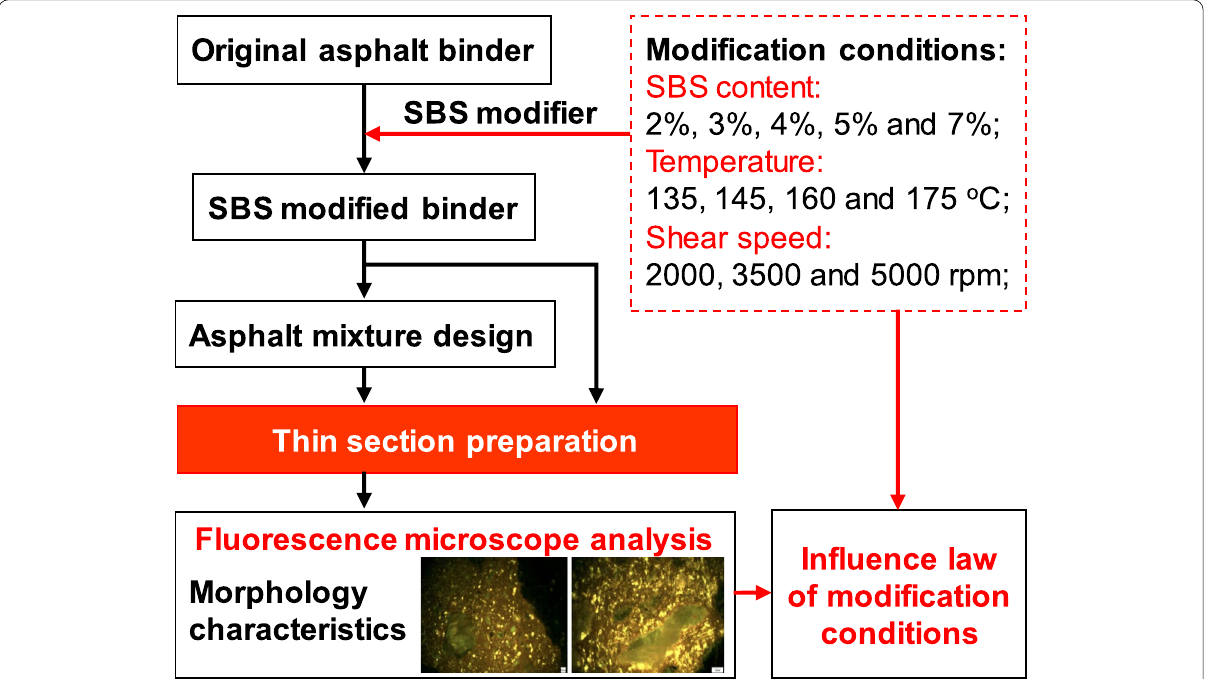
Fig. 1 Research program for SBS morphology characterization in asphalt